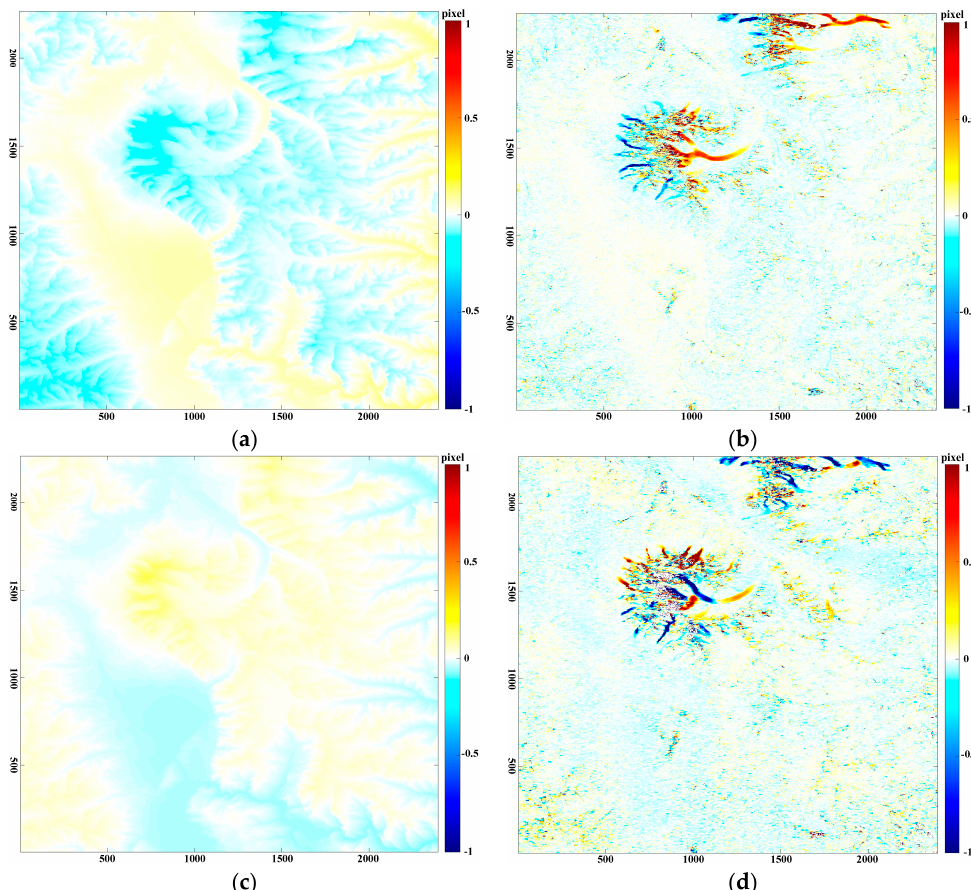
Figure 5. The topographic effect compensation operation: ( a , c ) are the offset signals corresponding to the topography in the range and azimuth directions, respectively; and ( b , d ) are the glacier-motion-related signals in both directions after the topographic effect compensation.